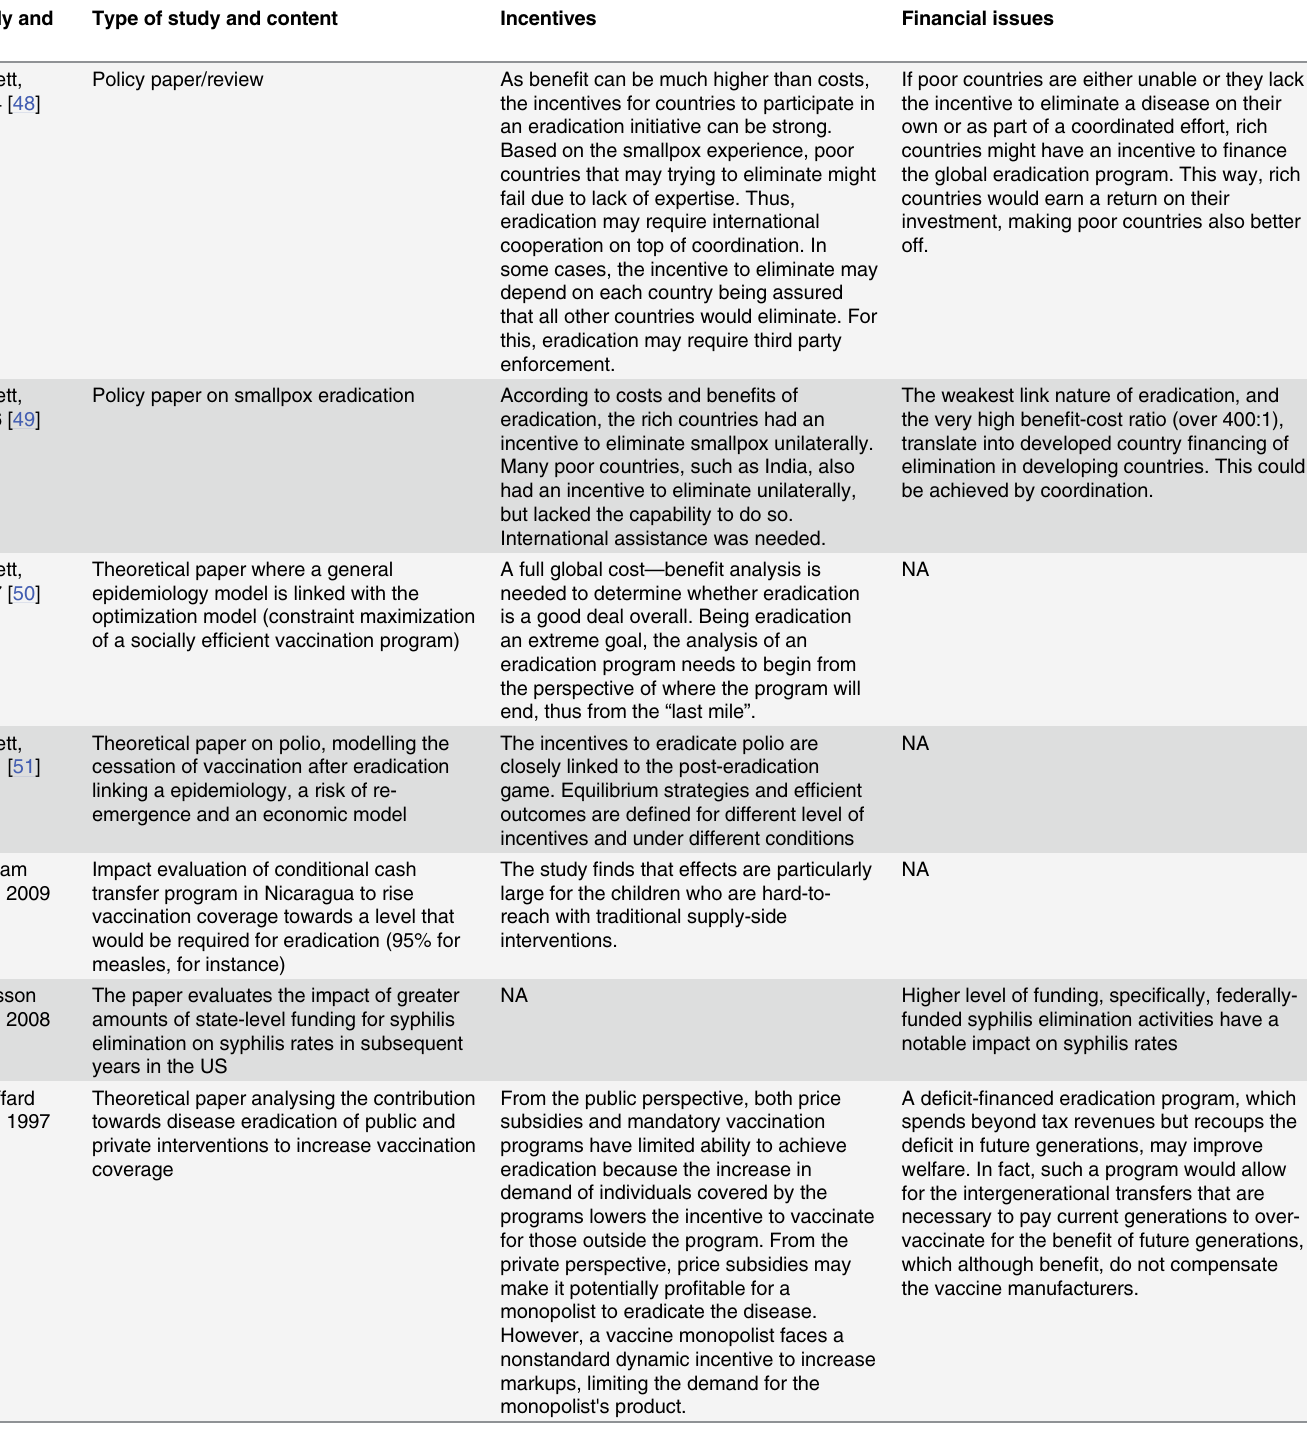
Table 3. How to eliminate/eradicate: the role of incentives and financial